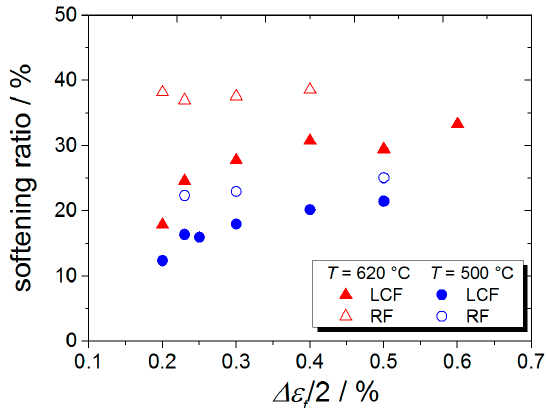
Figure 19. Softening ratio as a function of strain amplitude of all LCF- and RF-tests (3 min hold time) at 500 °C and 620 °C.